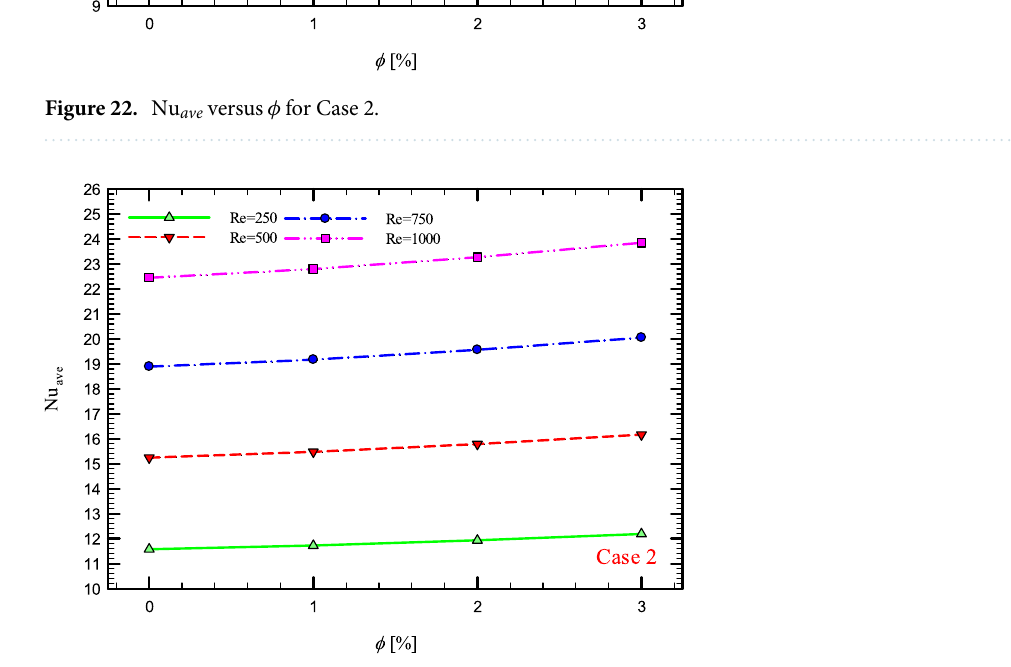
Figure 23. Nu ave versus φ for Case